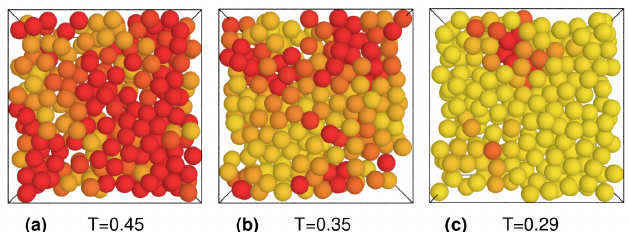
Figure 8: Spatial distribution of the average displacements e 2 for three stationary points sampled in the ternary mixture (a) well above ( T = 0.45), (b) around ( T = 0.35) and (c) at the mode-coupling temperature ( T = 0.29). Only particles in a vertical slab of thickness 2 σ are shown. The color coding interpolates between yellow ( • ) for particles with e 2